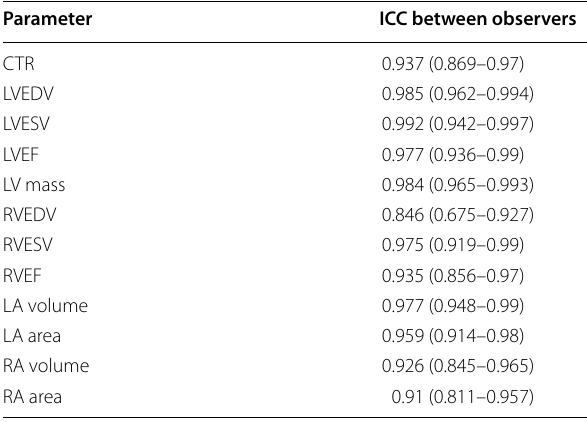
Table 2 Interobserver agreement demonstrated as intraclass correlation coefficient (ICC) for measuring CTR and cardiac MRI